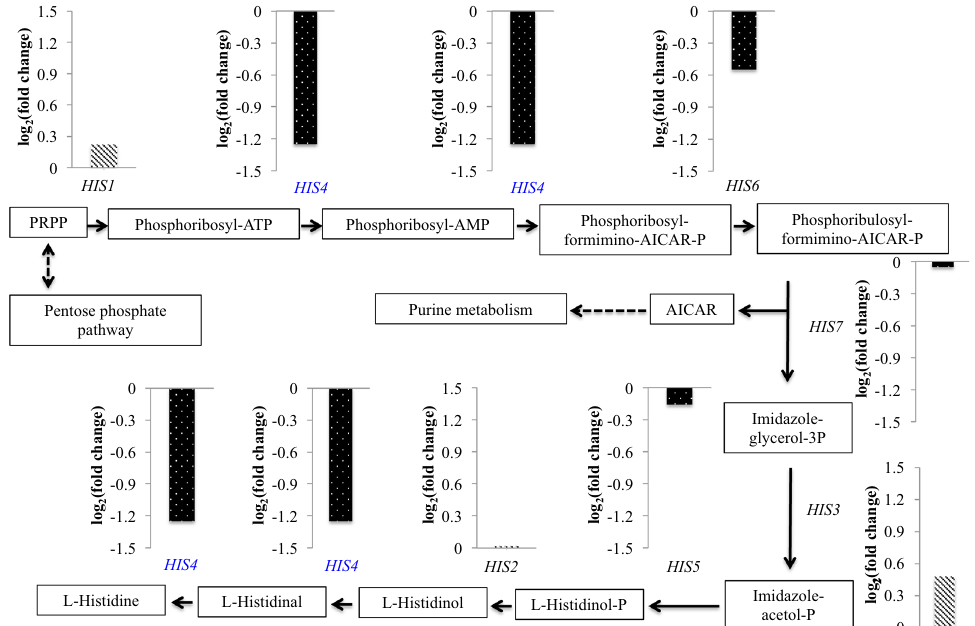
Figure 2. Schematic representation of MIG1 -disruption effects on the expression of HIS genes for histidine biosynthesis in K . marxianus . The ratio of the transcriptional level of each gene in Kmmig1 to that in the parental strain is presented by log 2 (fold change). The log 2 (fold change) values of the up-regulation are represented as backslash columns, while values of the down-regulation are represented as dotted columns. Further details are given in Supplementary Information File